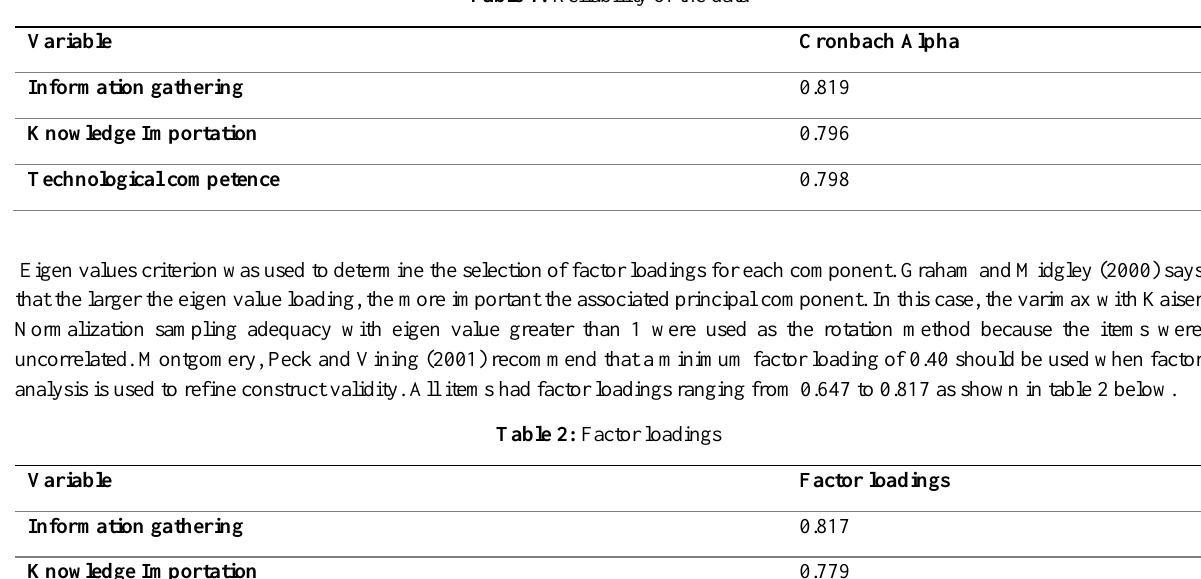
Table 1: Reliability of the data